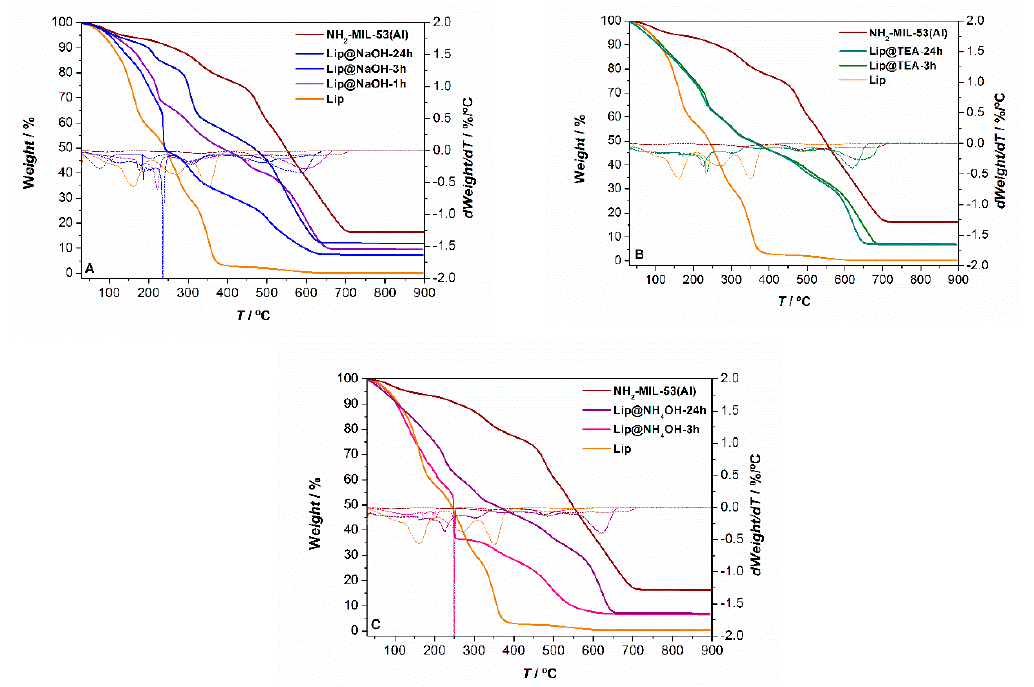
Figure 2. Thermogravimetric analysis—TGA—(left Y-axis, solid lines) and differential thermogravimetric—DTG—curves (right Y-axis, dashed lines) curves of: ( A ) The NH 2 -MIL-53(Al)-NaOH-24 h material (wine lines), the lipase extract (orange), and biocatalysts Lip@NH 2 -MIL-53(Al)-NaOH- x after 1 h (violet), 3 h (blue), and 24 h (cyan) of preparation; ( B ) of the NH 2 -MIL-53(Al)-NaOH-24 h material (wine), the lipase extract (orange), and biocatalysts Lip@NH 2 -MIL-53(Al)-TEA- x after 3 h (olive) and 24 h (dark cyan) of preparation; and ( C ) of the NH 2 -MIL-53(Al)-NaOH-24 h material (wine), the lipase extract (orange), and biocatalysts Lip@NH 2 -MIL-53(Al)-NH 4 OH- x after 3 h (pink) and 24 h (purple) of preparation.